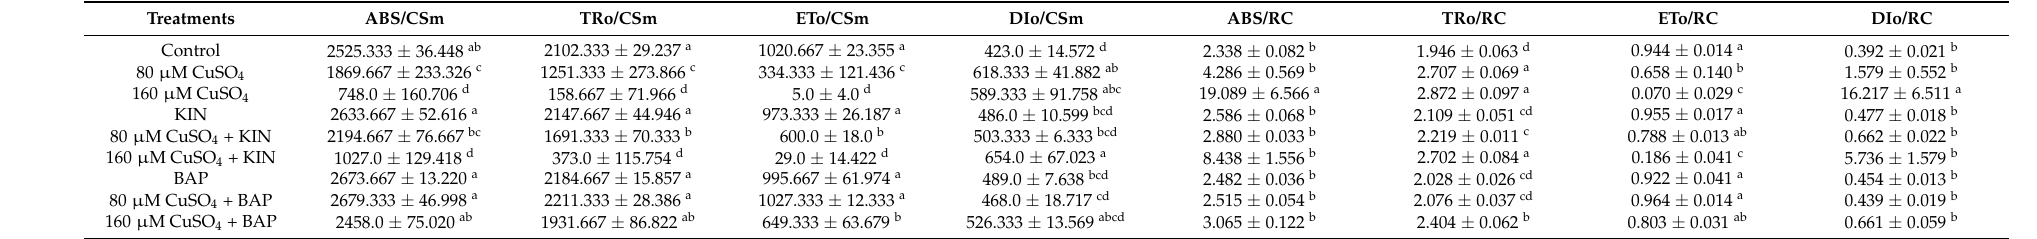
Table 3. The flourescence parameters showing phenomenological energy fluxes per cross-section approximated by maximal fluorescence Fm (CSm) and specific membrane model per a single reaction center (RC) in the cotyledonary leaves of R. communis for 4 day of exposure to CuSO 4 (80 and 160 µ M) and cytokinin (KIN and BAP) treatments in Hoagland’s nutrient medium. ABS/CSm